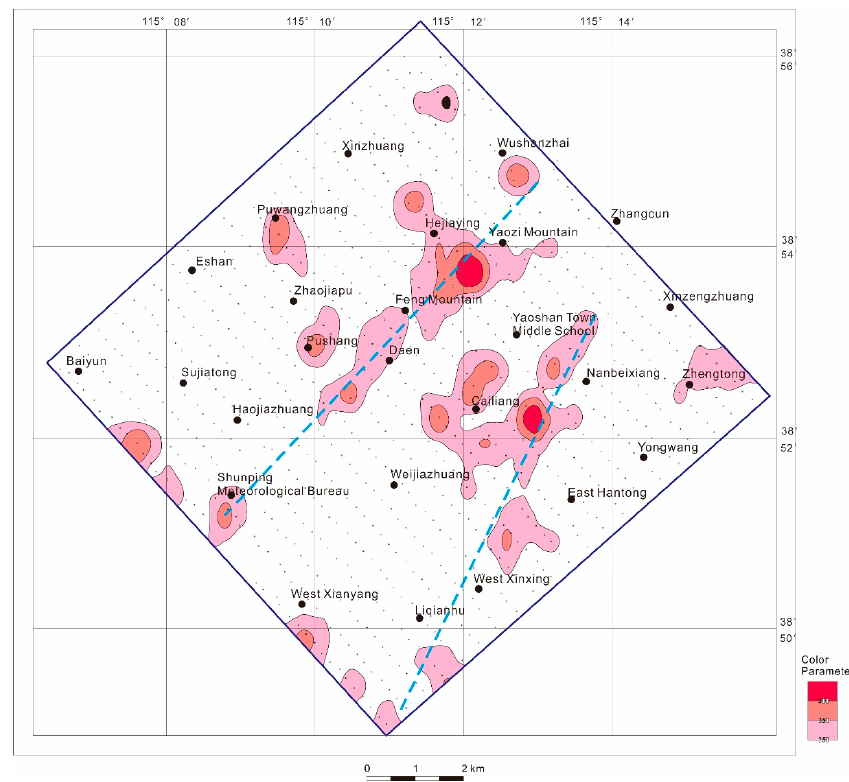
Minerals 2022 , 12 , x FOR PEER REVIEW Figure 8. Abnormal distribution of Hg in soil. Figure 8. Abnormal distribution of Hg in soil.